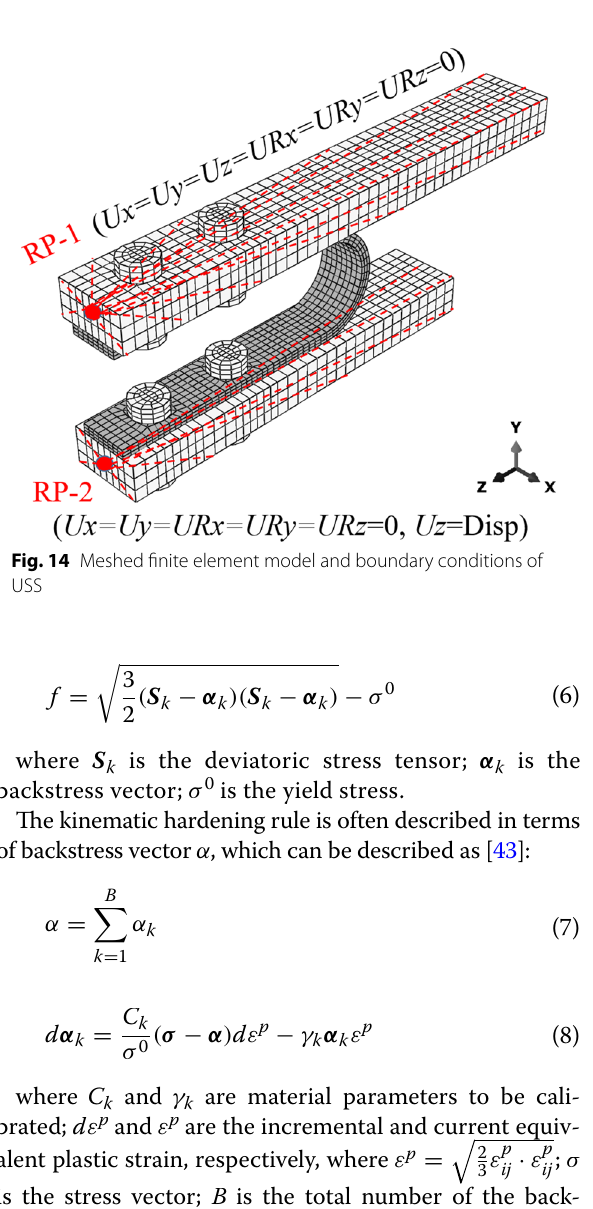
tube is completely fixed. When a brace works, the inner part is ‘pulled’ or ‘pushed’ along the longitudinal direction of the brace. The relative displacement between outer tube and inner plate deforms the USSs (with an in-plane mode) which are located between them. Theoretically, the total damping force of the brace is simply provided by the USs installed in it, although there may exist some inevitable friction in practice. It is noteworthy that the number of the USs can be adjusted according to the design requirement.